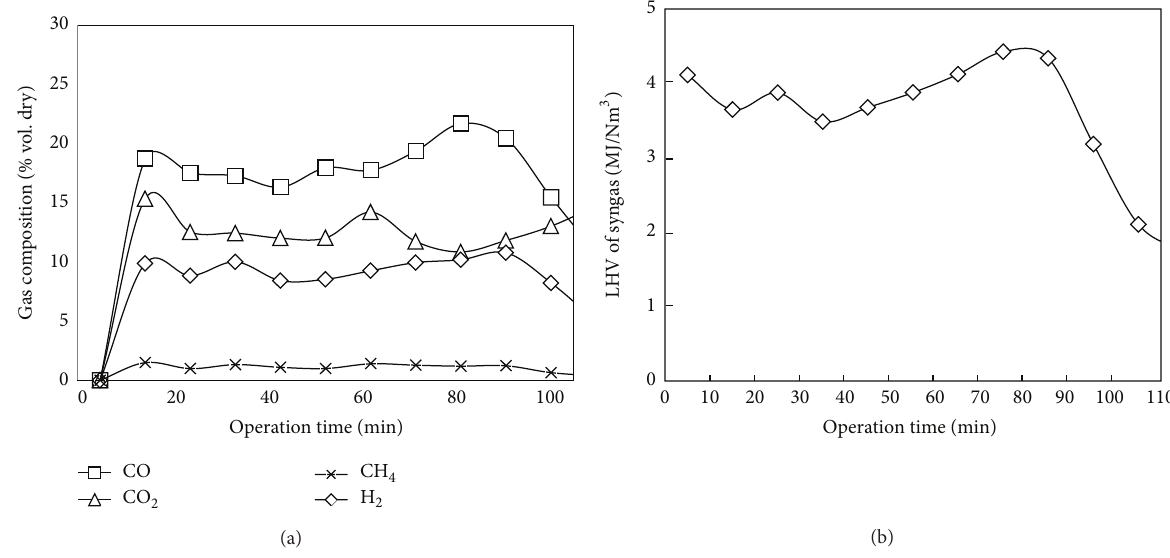
Figure 5: Variation of gasification output with operation time (a) syngas composition, (b) syngas heating value.